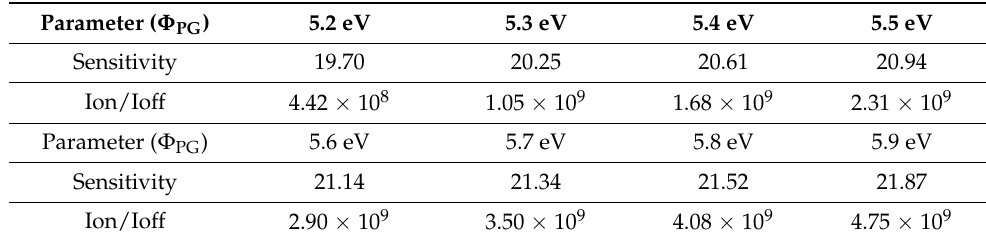
Table 4. The variation of the sensitivity and switch ratio with different Φ PG (Vgs = 2.0 V, Vds = 1.0 V, Φ Φ M1 = 4.3 eV, M2 = 3.9